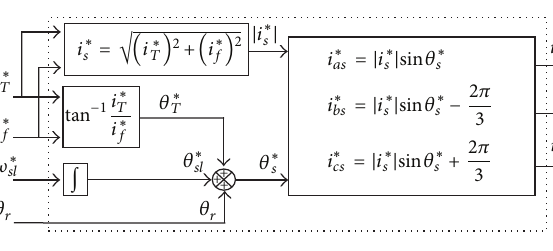
Figure 9: Stator current